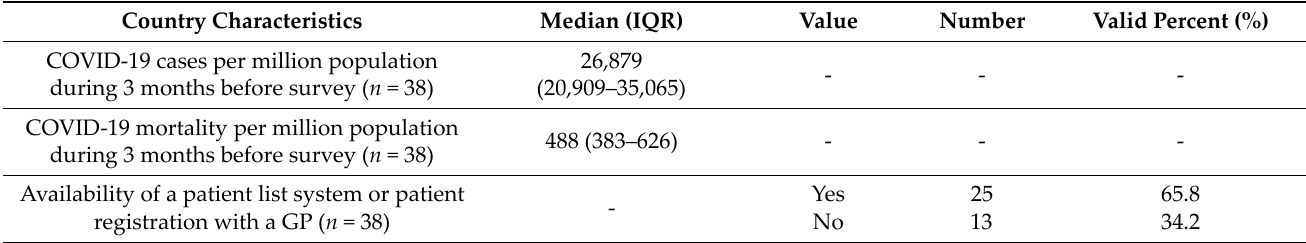
Table 3. A description of the country characteristics of the 38 participating